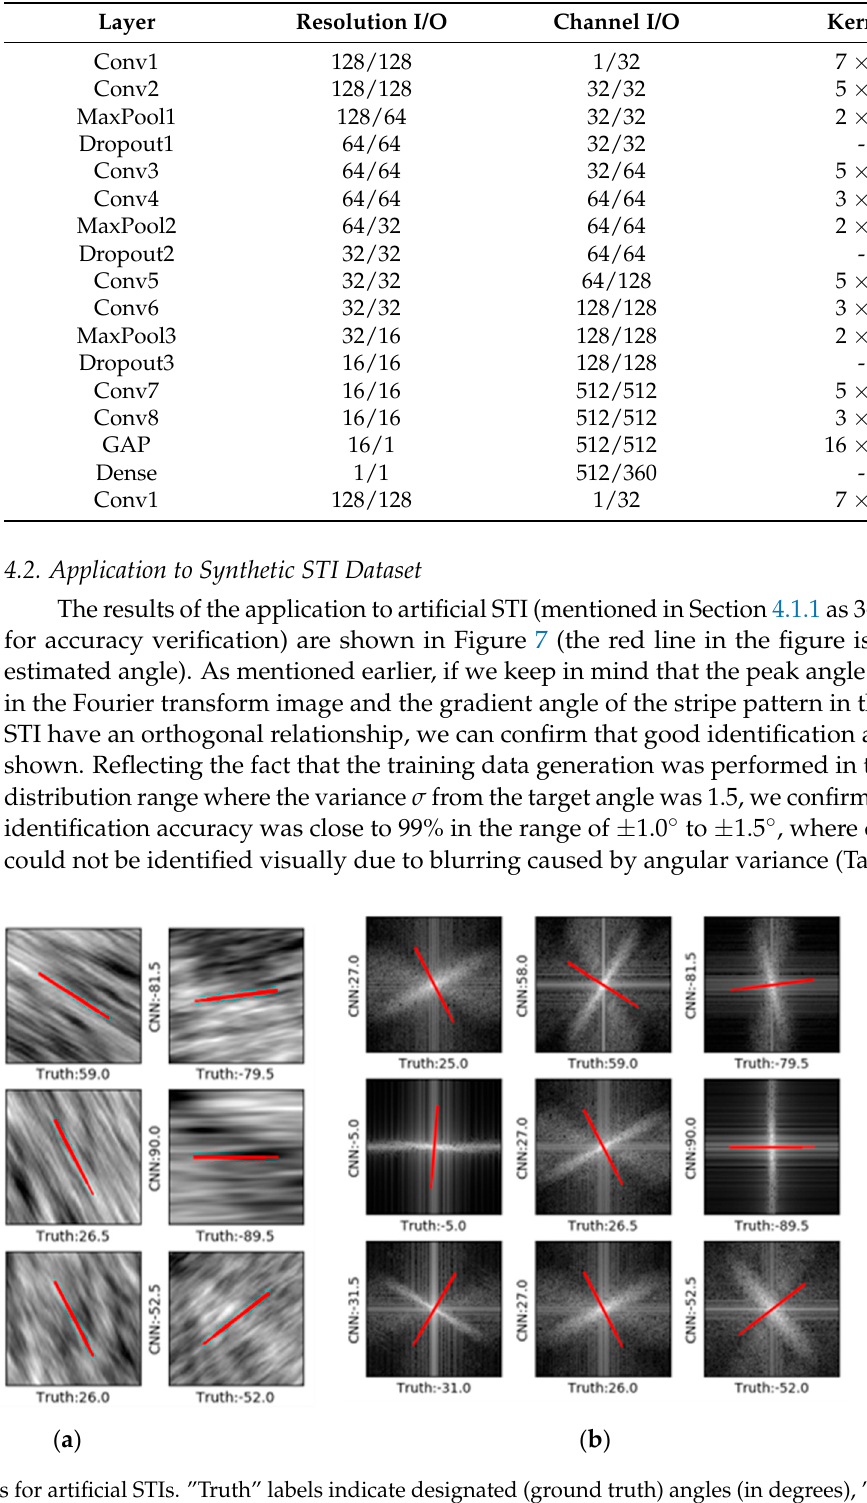
Table 2. The details of the CNN model.